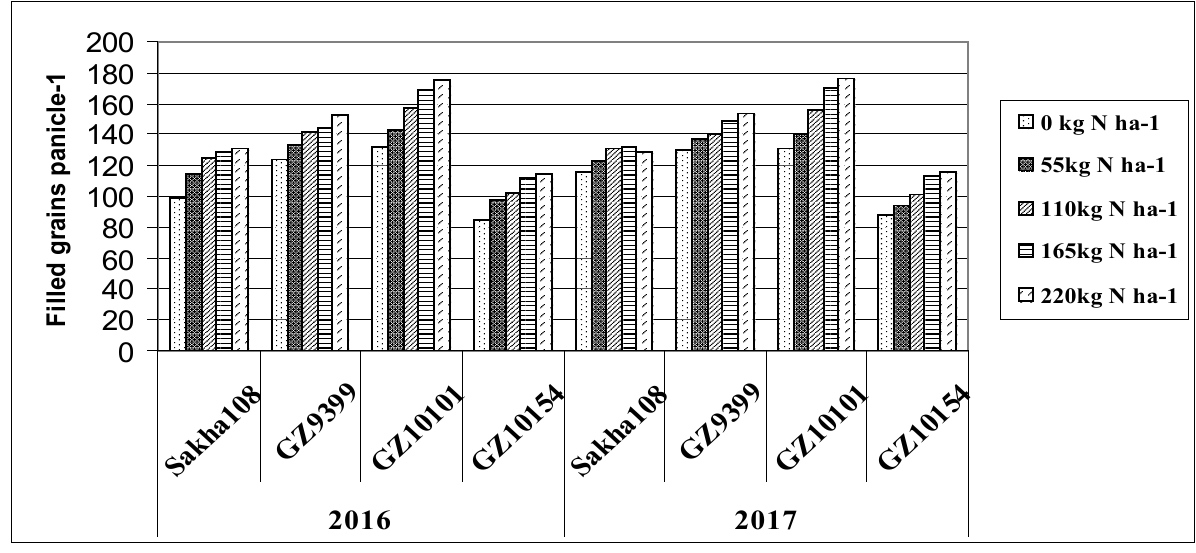
Figure 3: Filled grains per panicle as affected by interaction between rice genotypes and N levels in 2016 and 2017